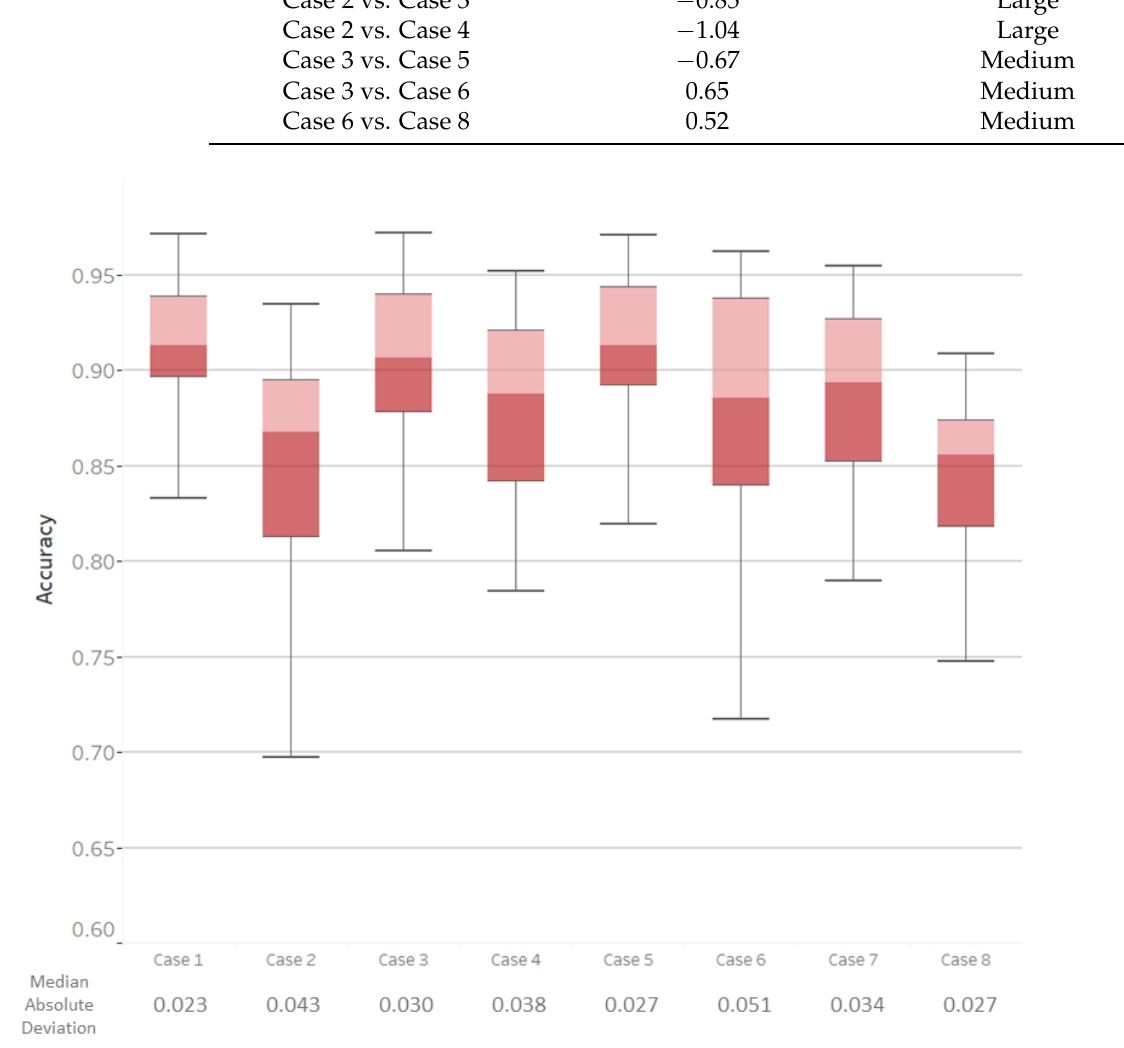
Figure 6. A box plot of the classification accuracy for all eight cases across all subjects with allowed run/sprint confusion. The line on the box represents the median, while the whiskers reach 1.5 times the interquartile range. The cases here refer to the cases that are defined in Figure